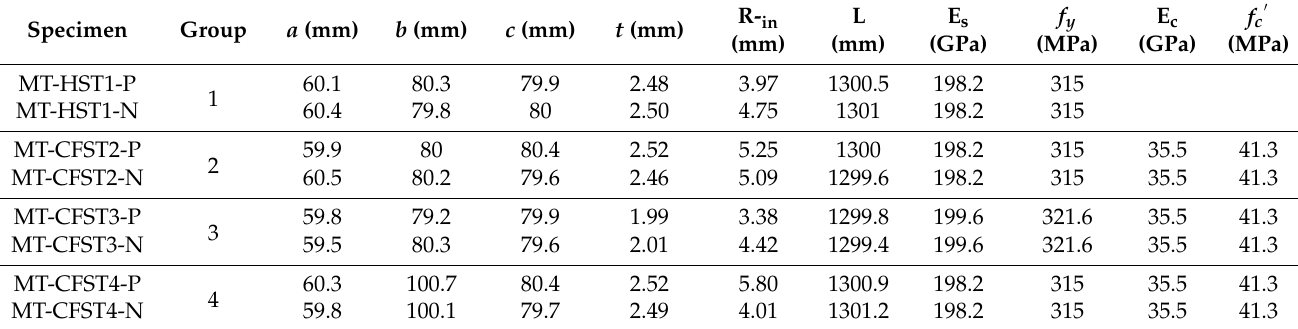
Figure 6. MT-HST specimens with transverse stiffeners. Table 1. Geometric and material properties of the